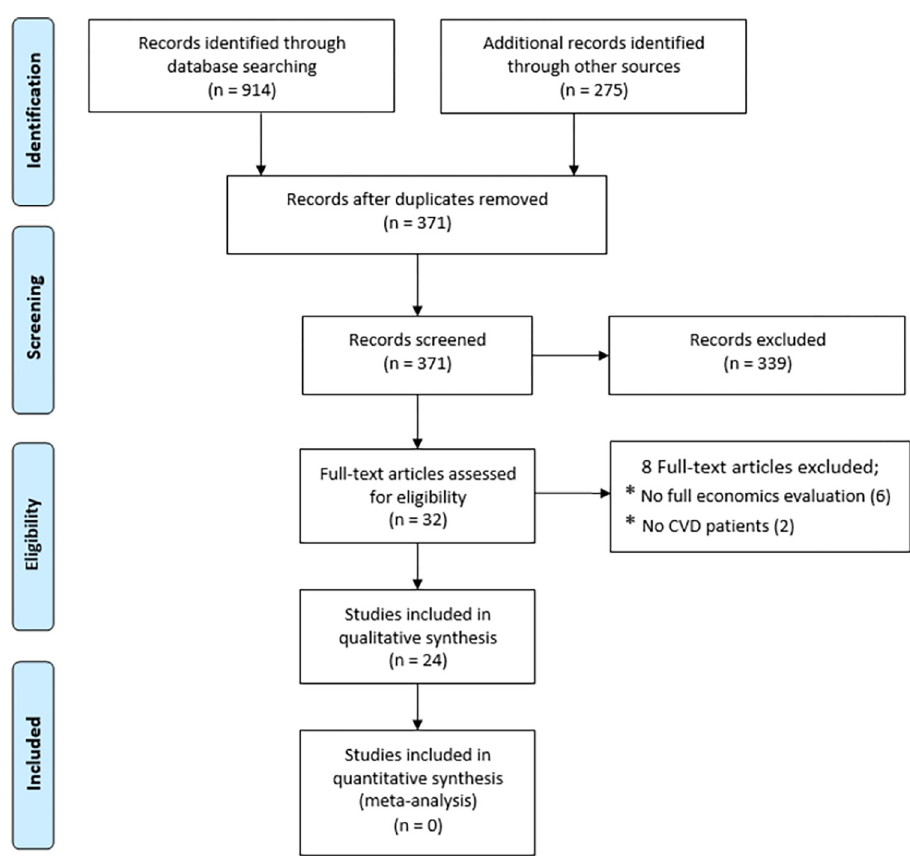
Fig 1. PRISMA flow diagram for study